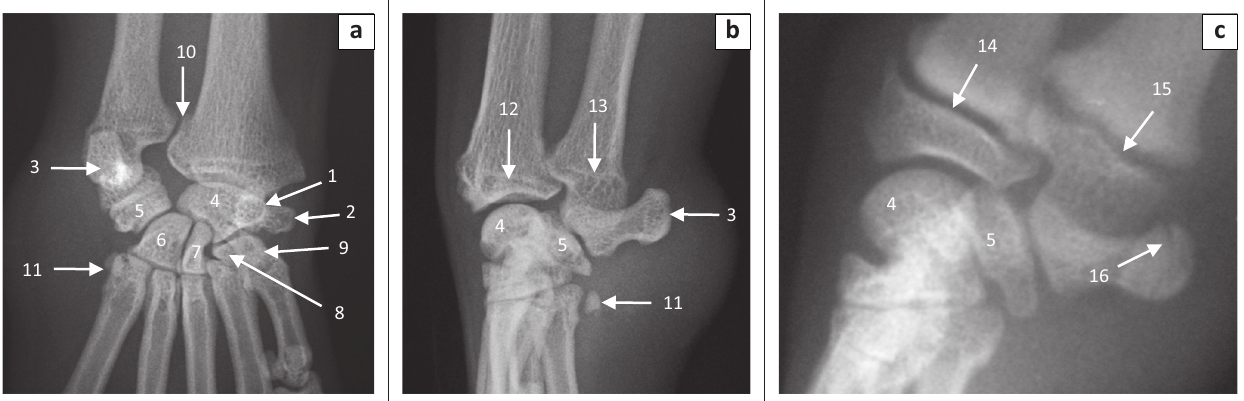
FIGURE 8: (a) Dorsopalmar and (b, c) mediolateral radiographs of the right carpus of red pandas. The carpus of a 1.4-year-old female animal is shown in (a) and (b), whereas that of a skeletally immature animal is shown in (c).